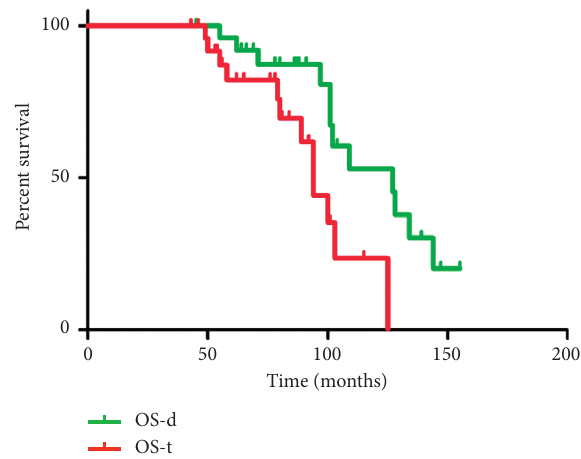
Figure 1: Tandem [ 90 Y]Y/[ 177 Lu]Lu-DOTATATE therapy: Kaplan–Meier estimators of the overall survival from the diagnosis (OS-d) in relation to the overall survival from the time of therapy (OS-t).